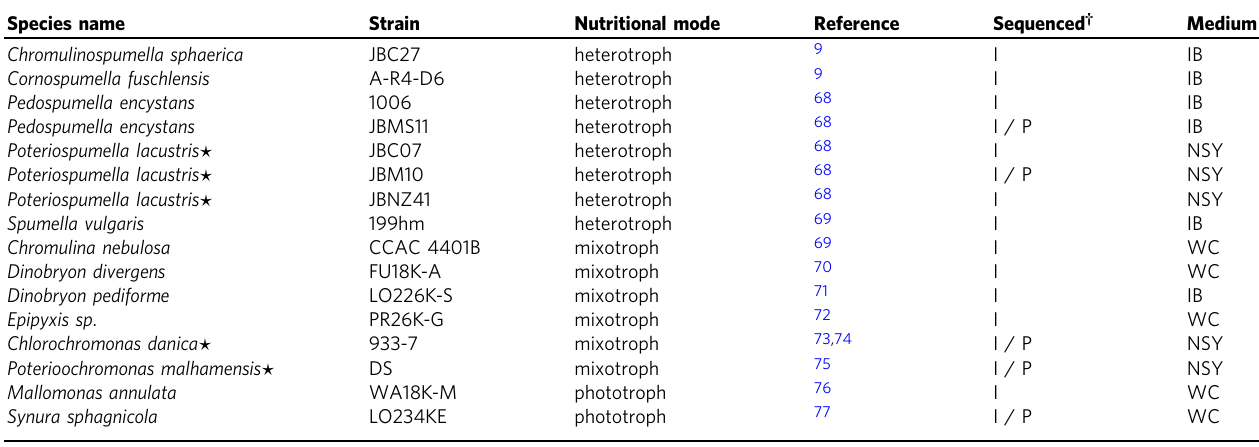
Table 5 General information of examined